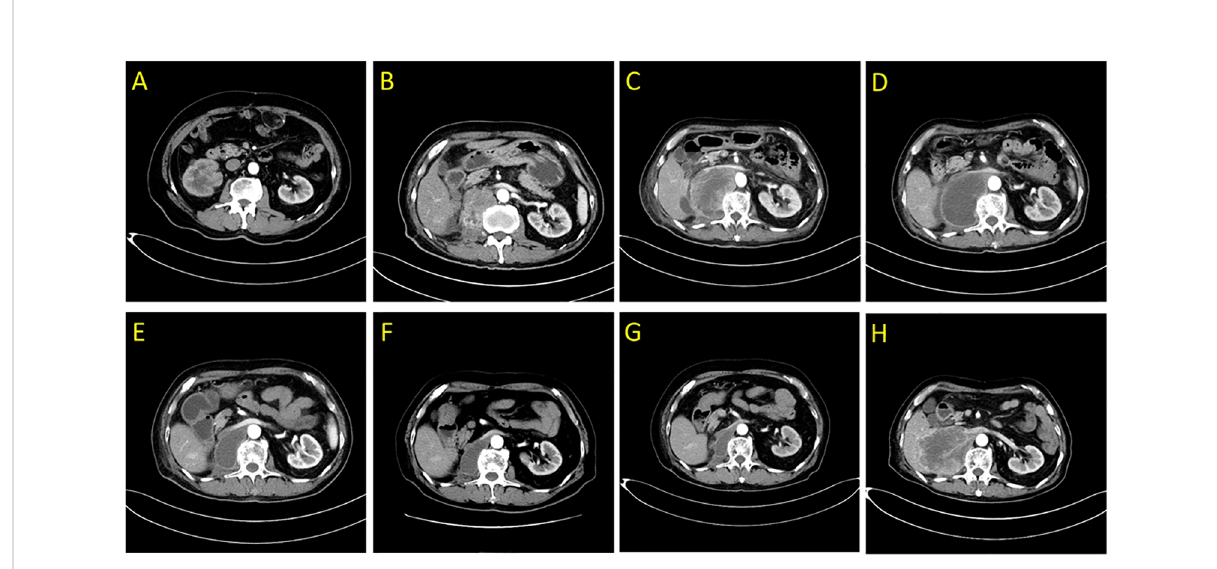
FIGURE 1 Abdominal enhanced computed tomography scans demonstrating the right posterior peritoneal tumor lesion. (A) at diagnosis in February 2020; (B) at disease relapse 4.5 months after RNU; (C) the tumor lesion was enlarged following 2 weeks of fi rst dose of tislelizumab treatment in July 2020; (D) liquefaction and cystic changes were observed within the tumor lesion following 6 weeks of tislelizumab combined with anlotinib treatment in August 2020; (E – G) continuous shrinkage of the tumor lesion following tislelizumab combined with anlotinib treatment in October 2020, January 2021, and May 2021, respectively; (H) disease progression following 20 months of tislelizumab combined with anlotinib treatment in February